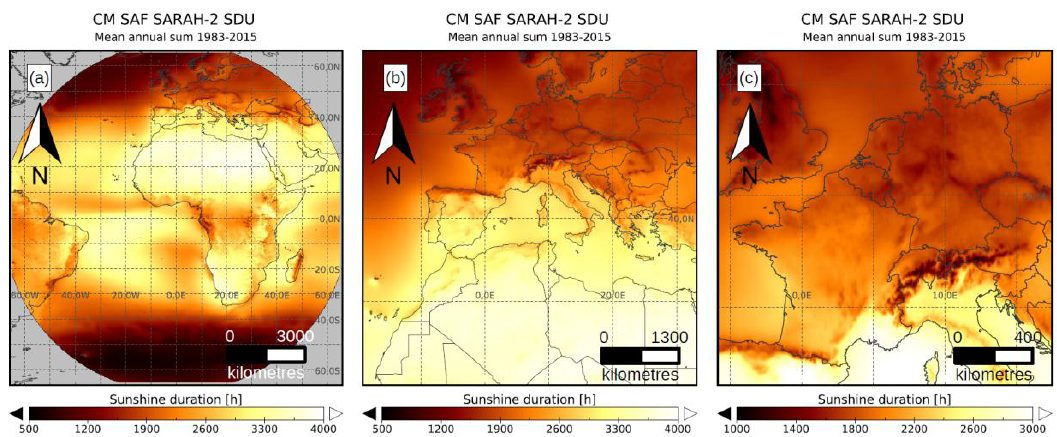
Figure 9. Mean annual sum (h) of SDU for the time period 1983 to 2015 for the Meteosat disk ( a ), Europe and North Africa ( b ), and Central Europe ( c ).